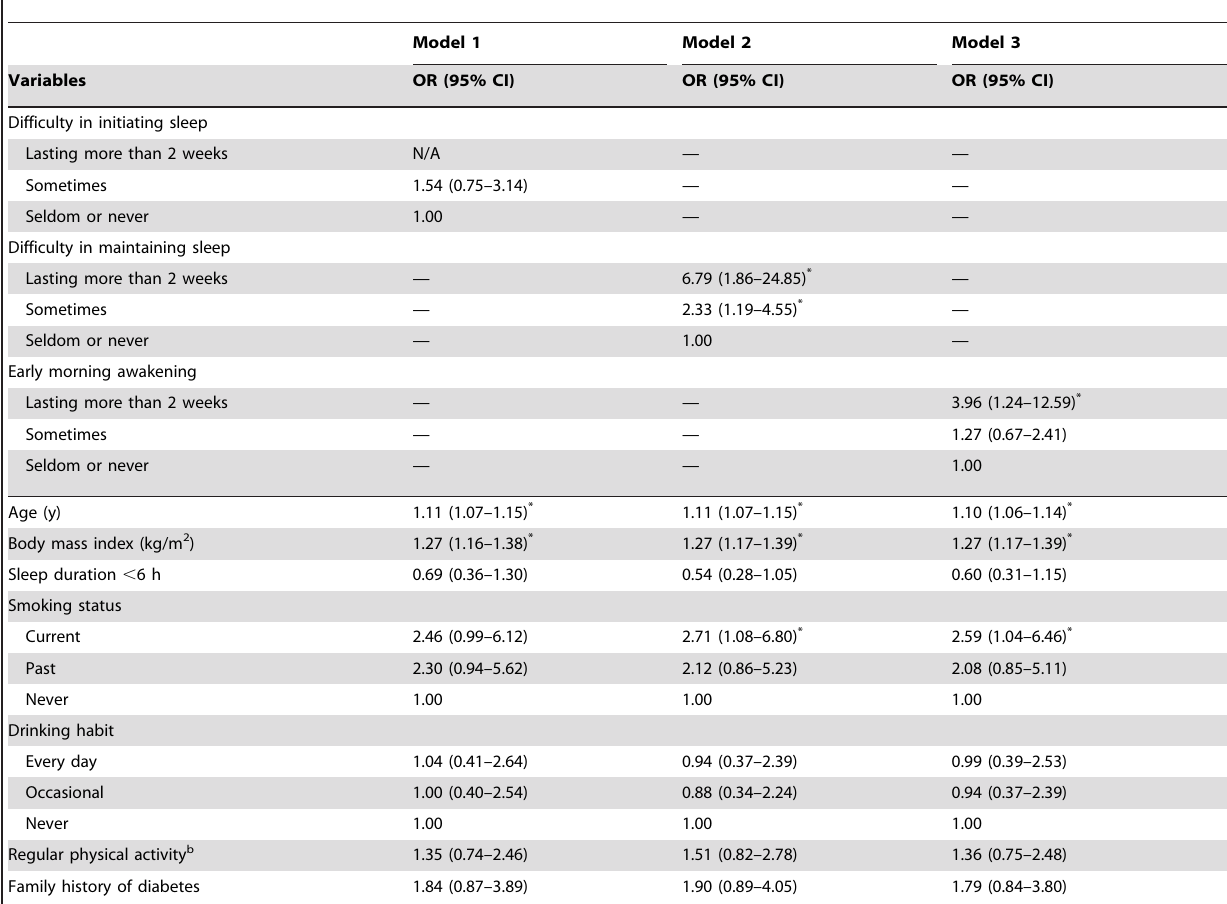
Table 2. Odds ratios (ORs) for high HbA 1ca according to each of 3 types of insomnia symptoms (n=